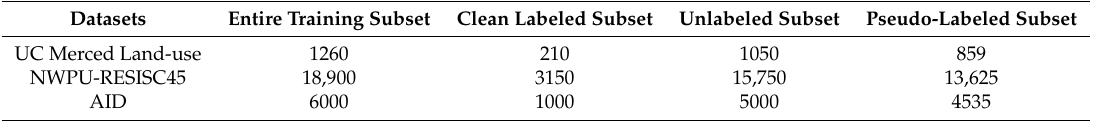
Table 2. Number of samples contained in different subsets. The unlabeled subset is 5 of the entire 6 training set. Pseudo-labeled subset is generated in unlabeled subset by the automatic labeling method trained with the clean labeled subset (i.e., 1 of the entire training set) as a clean subset. 6 Datasets Entire Training Subset Clean Labeled